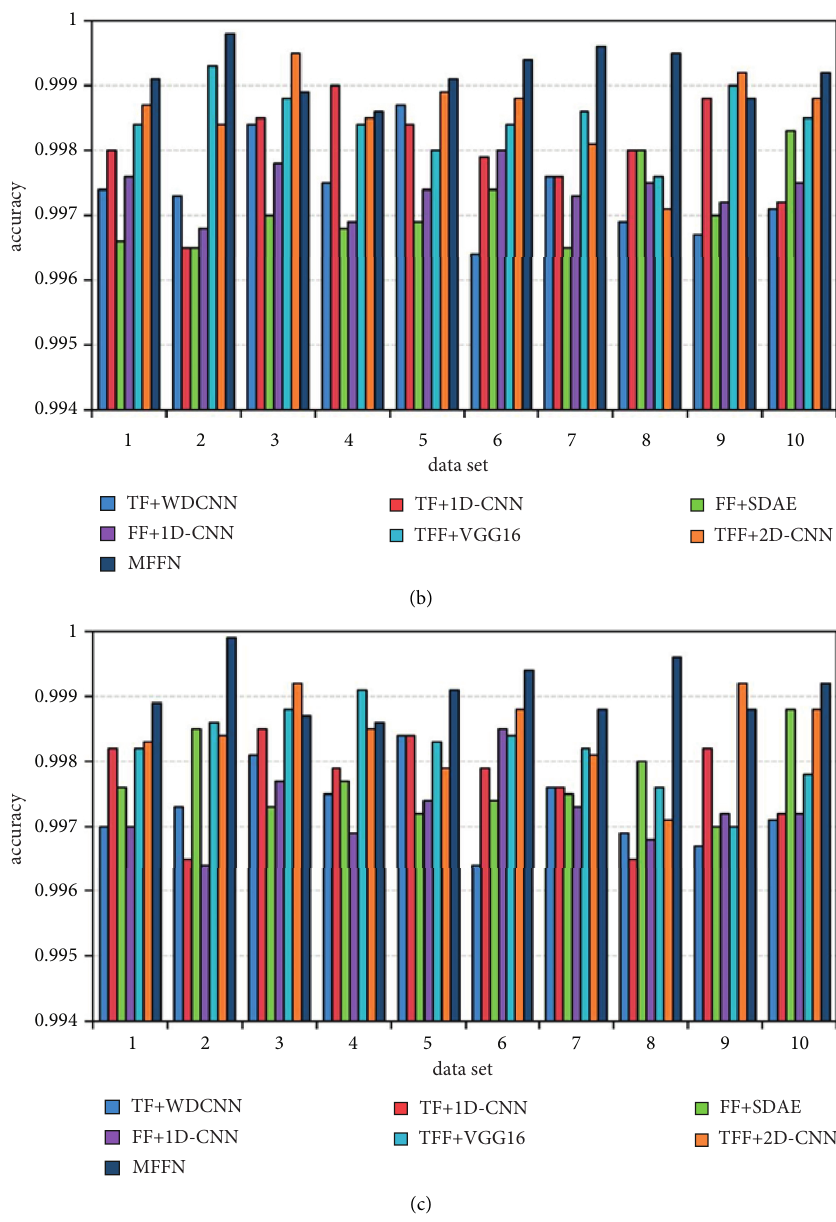
Figure 6: Experimental comparisons on (a) CWRU, (b) Jiangnan, and (c) Paderborn datasets.